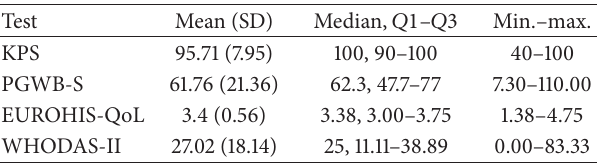
Table 2: Descriptive statistics of the 4 tests administered to the sample.